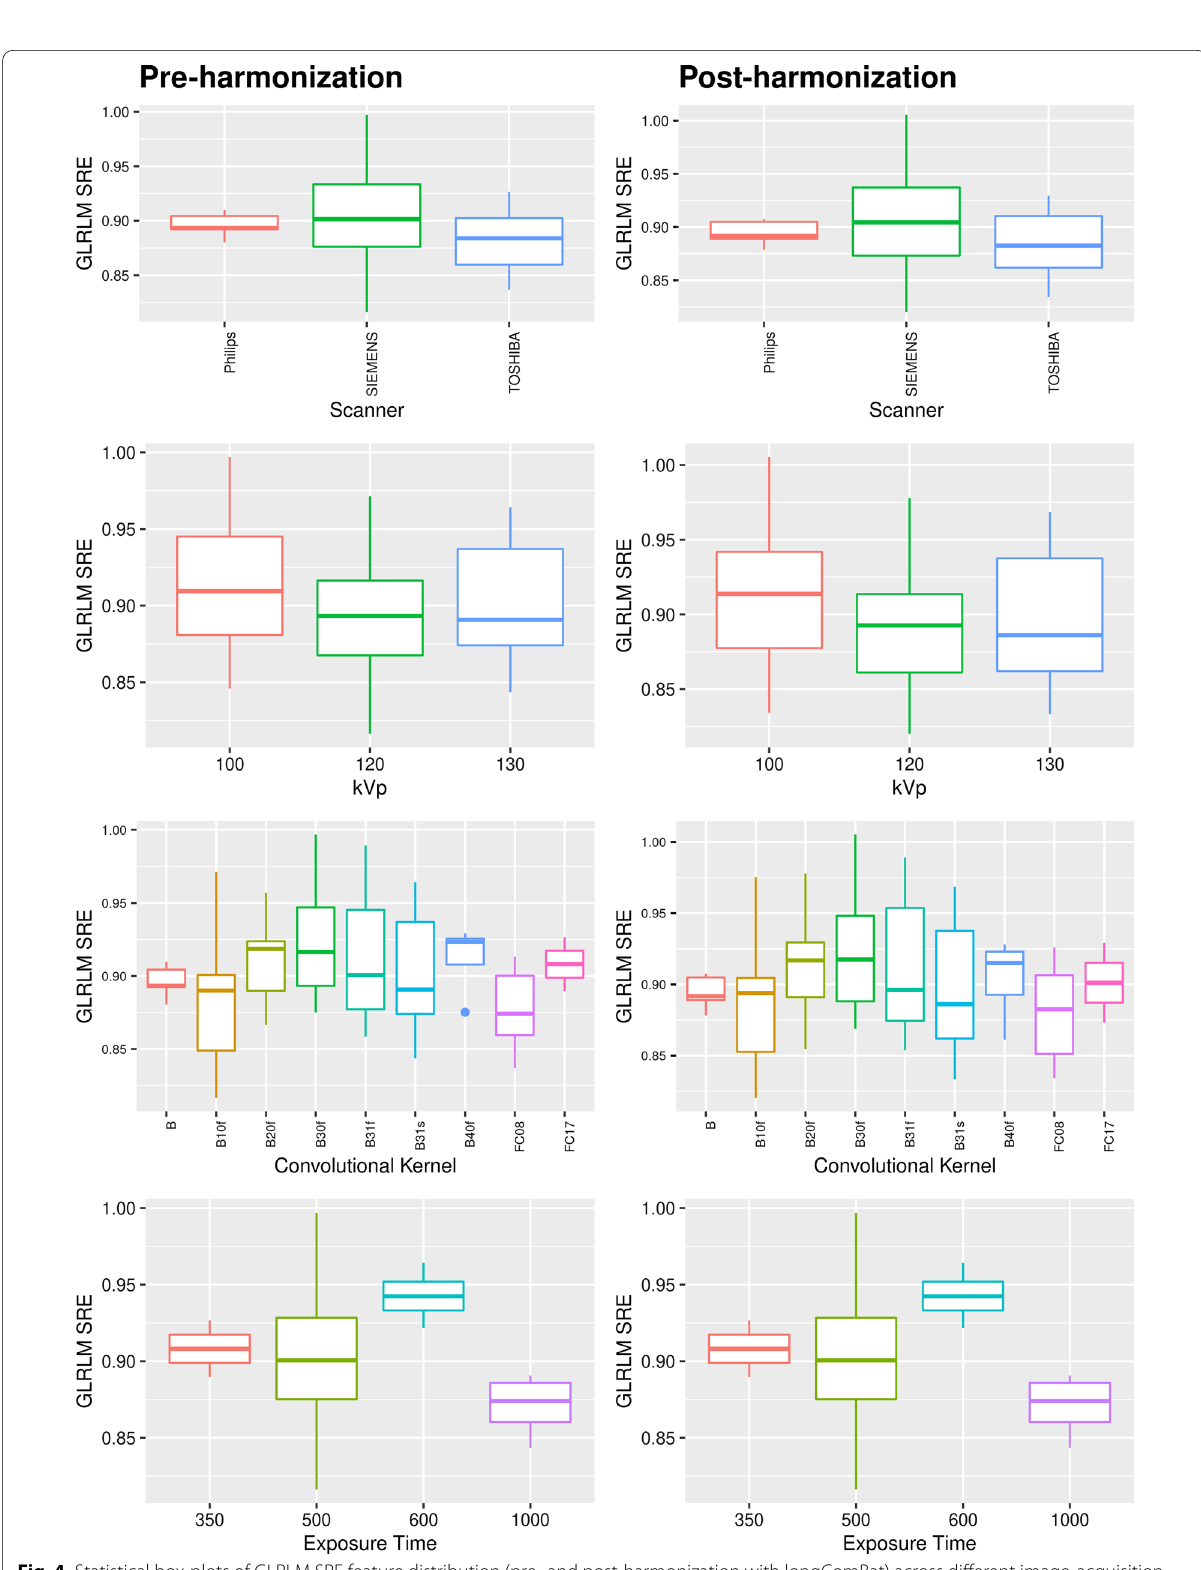
Fig. 4 Statistical box-plots of GLRLM SRE feature distribution (pre- and post-harmonization with longComBat) across different image-acquisition parameters: Scanner, kVp, Convolutional Kernel, Exposure